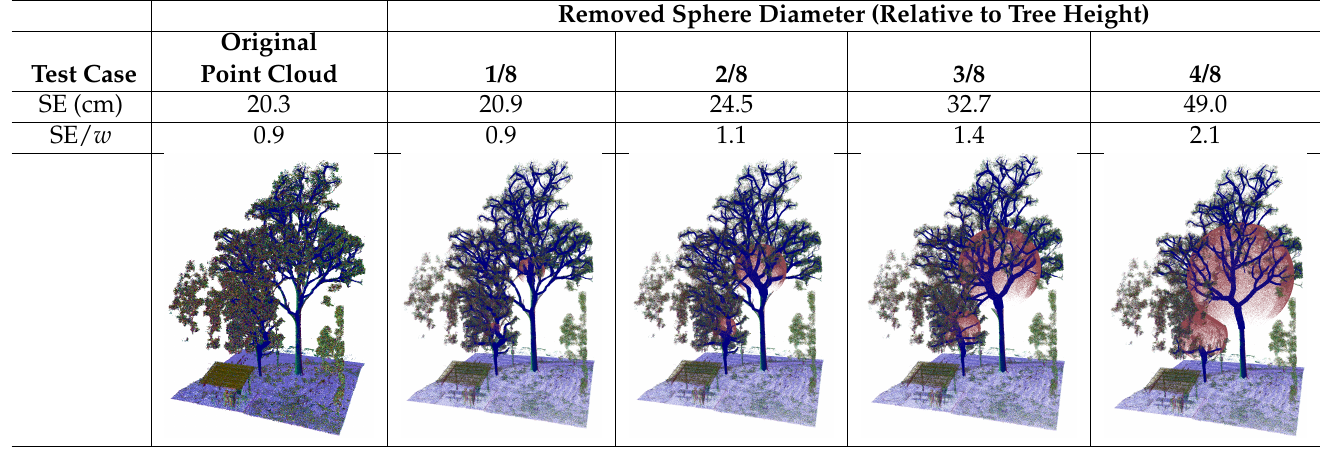
Table 6. Occlusion study: the optimisation procedure is repeated after removing spheres ranging in diameter from 1/8 to 1/2 of each trees height (red) from their geometric centre, replicating an occlusion. Even with a significant proportion of point removed from the cloud, little change is observed in the reconstructed trees